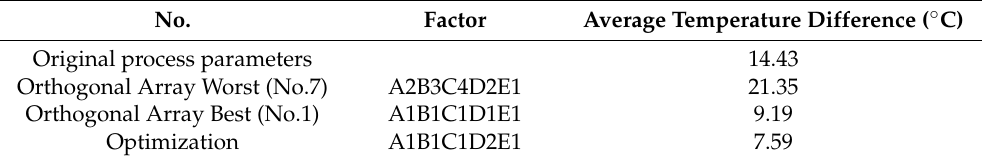
Table 12. Average Temperature Difference Validation Test.